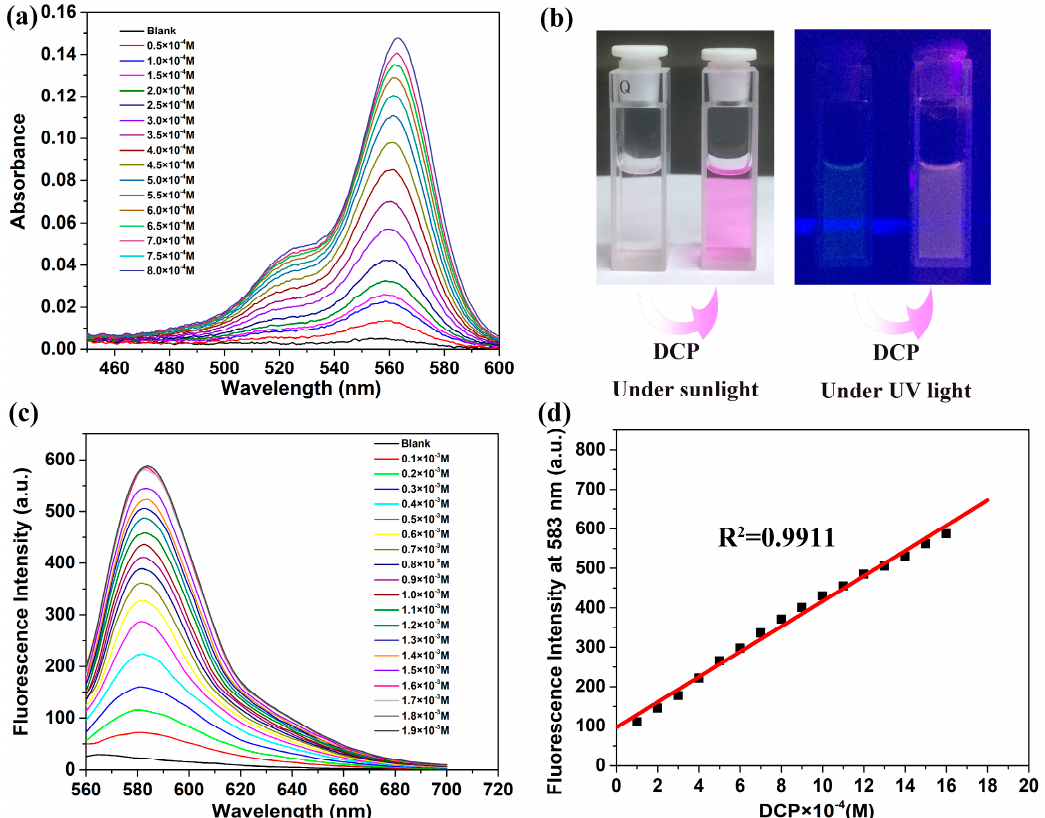
Figure 1. ( a ) Absorption spectra of RB-CT (1.0 × 10 − 5 M) upon the addition of DCP (0.5 × 10 − 4 –8.0 × 10 − 4 M) in CH 3 CN (3% Et 3 N). ( b ) The images of the RB-CT solution before and after the addition of DCP under sun light (left) and UV light (right). ( c ) Fluorescence spectra of RB-CT (1.0 × 10 − 6 M) at λ ex = 540 nm, upon the addition of DCP (0.1 × 10 − 3 –1.9 × 10 − 3 M) in CH emission intensity of RB-CT at 583